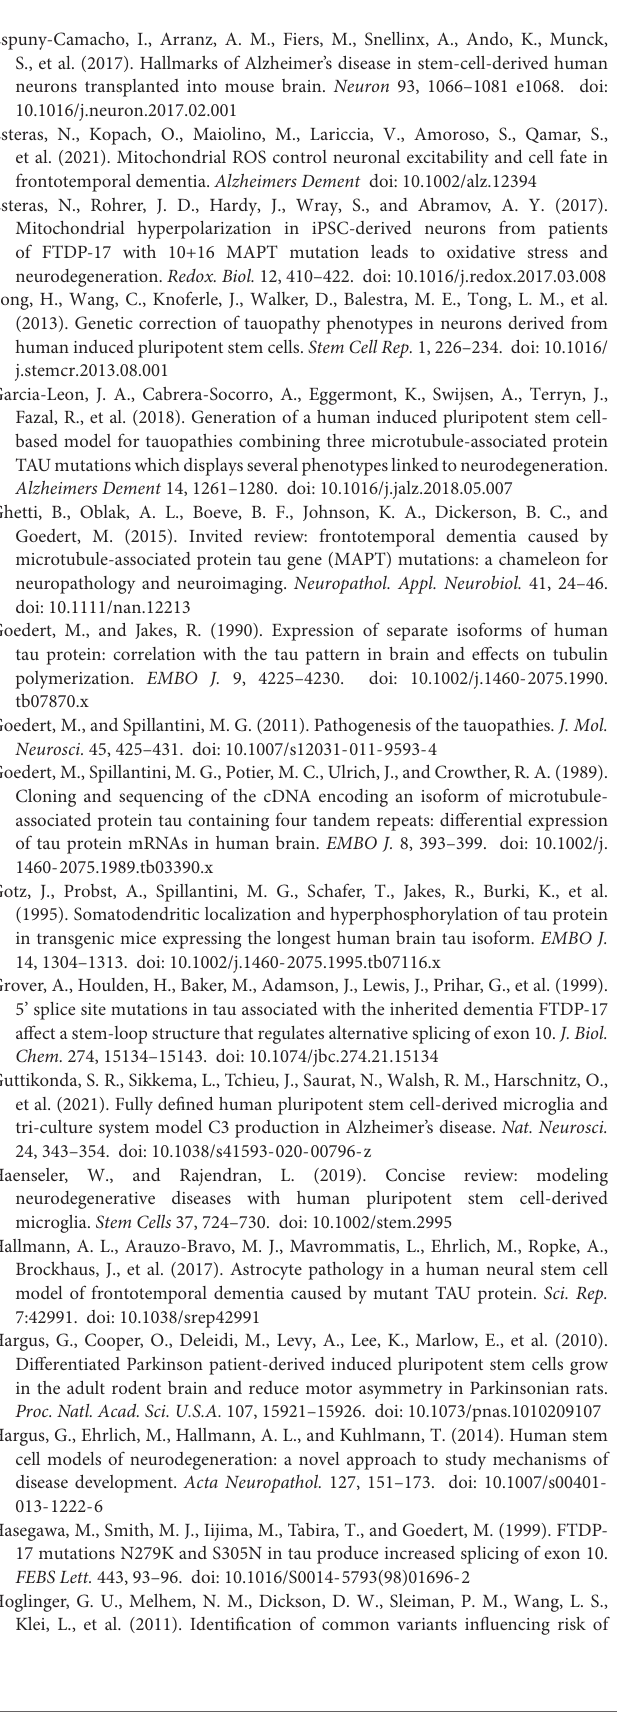
Frontiers in Cell and Developmental Biology |